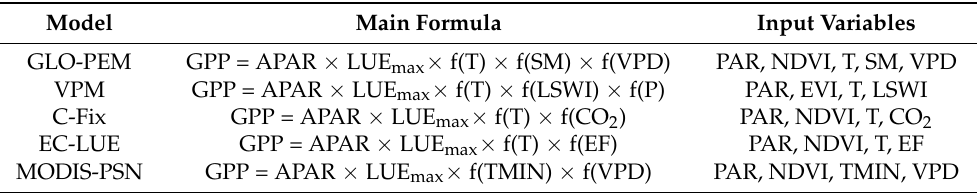
Table 2. The Light Use Efficiency (LUE) models used in this study.